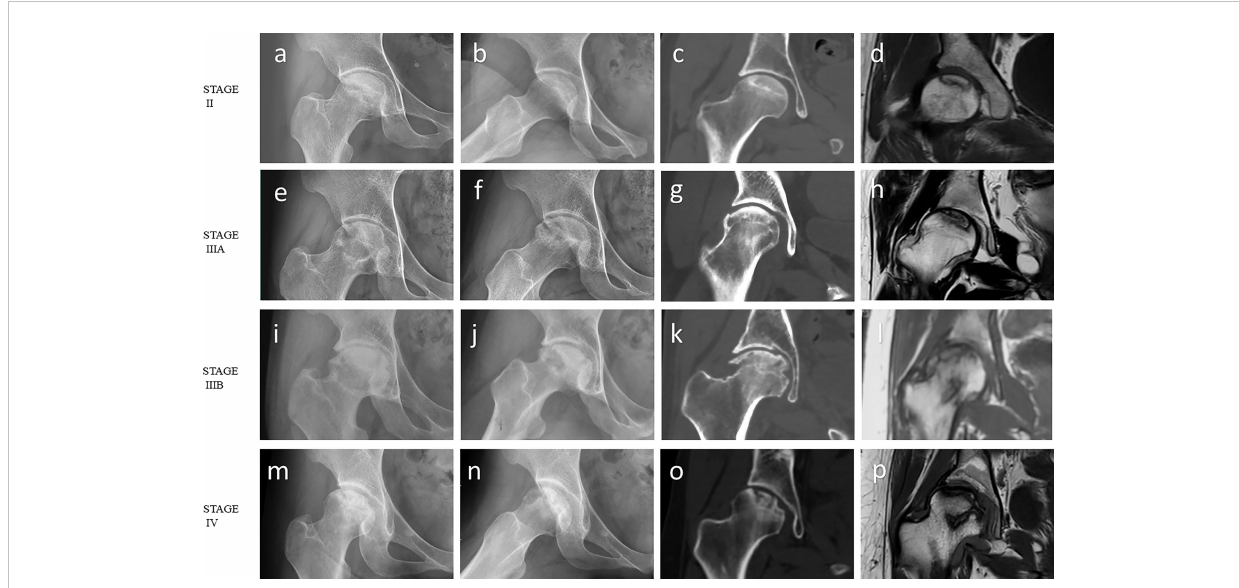
FIGURE 1 Imaging features of ONFH. (A-D) ARCO stage II: The radiograph showed focal osteoporosis and osteosclerosis in the femoral head. However, there were no signs of collapse, and the femoral head remained spherical on the coronal CT image and T1-weighted MR image. (E-H) ARCO stage IIIA: Subchondral fracture and fl attening of the femoral head was observed on the radiograph or coronal CT image. Femoral head depression was less than 2 mm. (I-L) ARCO stage IIIB: Femoral head depression was more than 2 mm. (M-P) ARCO stage IV: Osteoarthritis of the hip joint with joint space narrowing was detected on the radiograph. Coronal CT image and T1-weighted MR image showed advanced degenerative alterations and entire joint destruction. Note: (A, E, I, M) Frontal radiograph; (B, F, J, N) Frog-leg lateral radiograph; (C, G, K, O) Coronal CT image; (D, H, L, P) Coronal T1-weighted MR